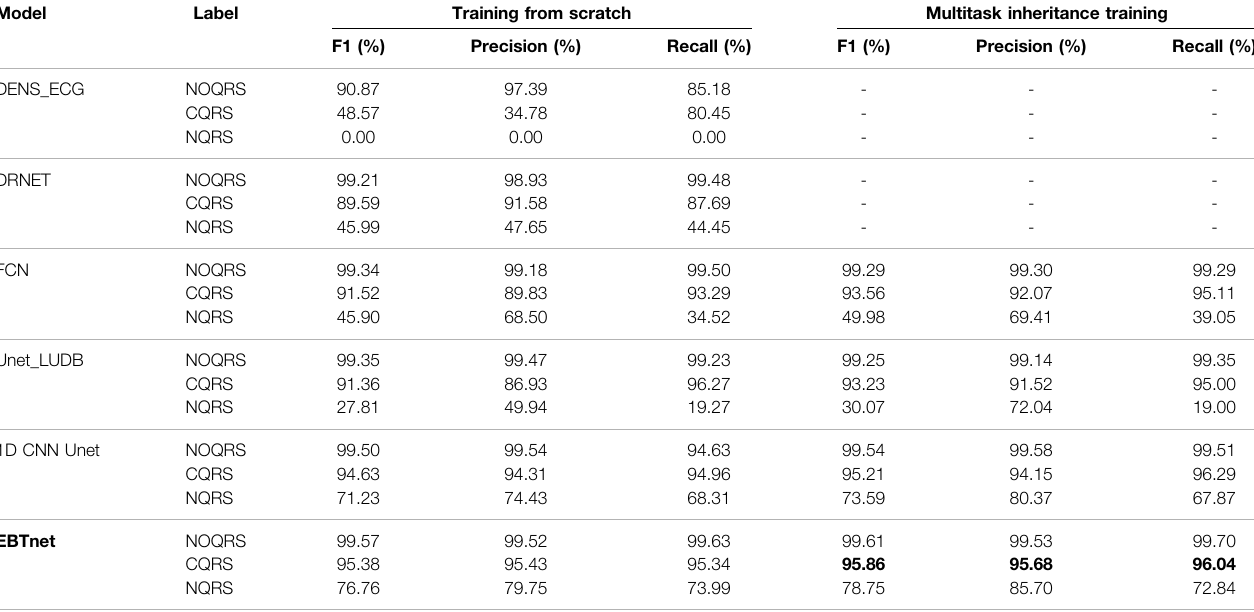
TABLE 4 | The comparison results of segmentation models in the intra-analysis. Model Label Training from